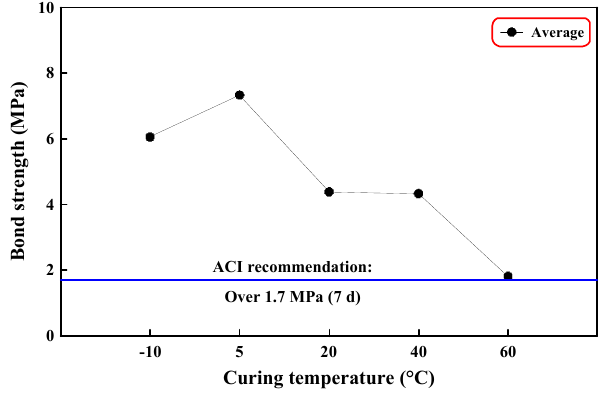
Figure 8. Effect of curing temperature on average bond strength.